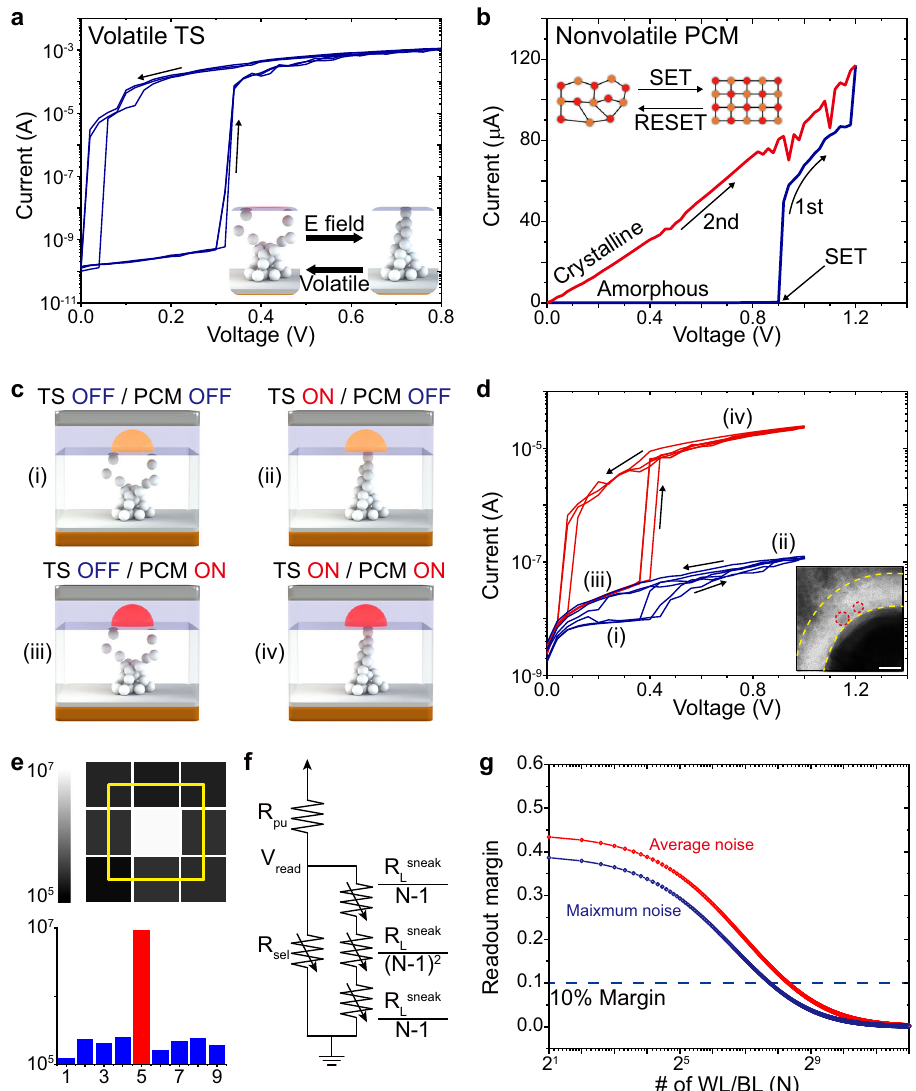
Fig. 2 Electrical characteristics of volatile TS, nonvolatile PCM, and uni fi ed TS-PCM. a Current-voltage (I-V) curve of volatile TS device presenting threshold switching at 0.33 V and spontaneous reset. b I-V curve of PCM showing nonvolatile resistive switching by voltage sweep (blue). The second sweep (red) exhibits a high current value, indicating the nonvolatile phase transition of the GST fi lm. c Schematic diagram of four stages in TS-PCM operation. Both TS and PCM layers are in the OFF state in stage (i) with high resistance. The TS layer is switched to the ON state in stage (ii) with relatively low resistance. The top PCM layer is switched to the ON state by Joule heating of the Ag fi lament in stage (iii), which shows high resistance due to the bottom TS layer. Both the TS and PCM layers are in the ON state in stage (iv), which shows the lowest resistance. d I-V curve of TS-PCM presenting the four stages illustrated in c . Inset shows a TEM image of the TS-PCM cell with Ag clusters in the SiO 2 matrix. Scale bar, 10 nm. e Resistance-based color map (upper panel) and bar graph (lower panel) of worst-case scenario that veri fi es the random-access capability of TS-PCM. f Illustration of circuit model utilized in the OBPU method. For a suf fi ciently large N , R L sneak /(N-1) 2 becomes negligible. g Calculated readout margin by OBPU method. The TS-PCM array can be scaled up to 316 × 316 for a 10% readout margin in average noise case (red curve). The maximum array size of TS-PCM is decreased to 214 × 214 in maximum noise case (blue bias above V th induces the formation of Ag CF, which results in TS-PCM cell are 216 μ W (129.6 nJ/bit) and 2.21 mW (0.33 nJ/bit), stage (iv) with low resistance of 4 × 10 4 Ω . The bottom TS layer using 2 V amplitude and 600 μ s width set pulse and 10 V amplitude operates in a volatile manner regardless of the top PCM layer and 50 ns width reset pulse, respectively. The reset current of TS- resistance, enabling the coexistence of volatile and nonvolatile PCM is ~230 μ A, which is lower than that of conventional PCM resistive switching characteristics. Note that the coexistence of devices due to the fi lament con fi nement effect 37,38 . Note that the power ef fi ciency of TS-PCM can be improved through the volatility and nonvolatility in TS-PCM is different from the volatile- optimization of measurement setups and the scaling of cell size, nonvolatile transition behaviors reported elsewhere. In volatile- owing to the low set and reset current values. The switching nonvolatile transition behavior, volatility is not maintained after the characteristics of TS-PCM can be modelled by the combination of nonvolatile switching of the device. The power consumption level of phase change memory and threshold switch 39 – 42 . Using TS-PCM has also been calculated in pulse measurement scheme chalcogenide-based resistor function, Fermi-like smooth blending (see Supplementary Fig. S14 for details). The set and reset power